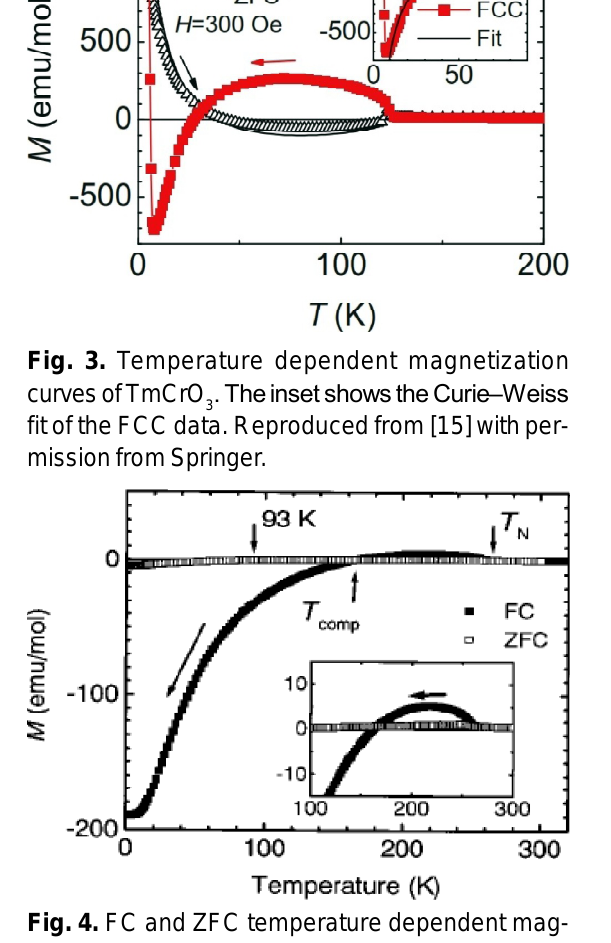
Pr CrO . The inset shows 0.5 0.5 3